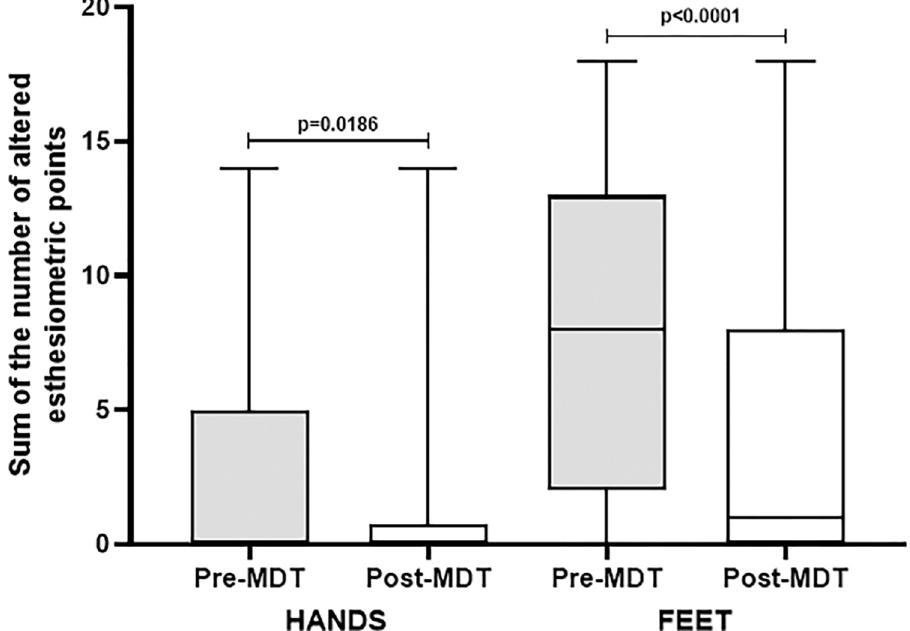
Fig 6. Evolution of the sum of the number of altered SWM-test points in the hands and feet of leprosy patients evaluated at diagnosis and at the end of WHO multidrug therapy in Jardino´polis (SP).